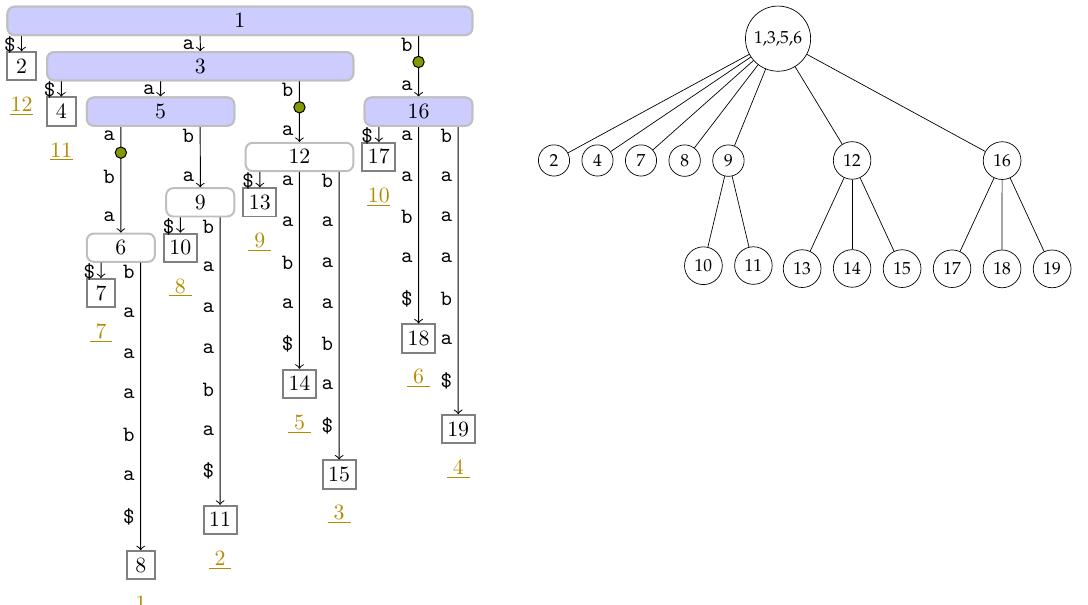
Figure 8. ( Left ) The suffix tree of T superimposed by the LZ trie (cf. Figure 7) computed on T = aaababaaaba$ . Blue ( ) colored ST nodes represent the explicit LZ trie nodes, i.e., those nodes that are present in ST . Implicit LZ trie nodes are represented by the small rounded nodes ( ). The edge witnesses are the nodes with the preorder numbers 3, 5, 6, 12, and 16. ( Right ) cpST of T described in Section 4.8. The label of a node is the list of preorder numbers of the nodes in its respective heavy path. For instance, the heavy path from the root contains the nodes with the preorder numbers 1, 3, 5, and 6.